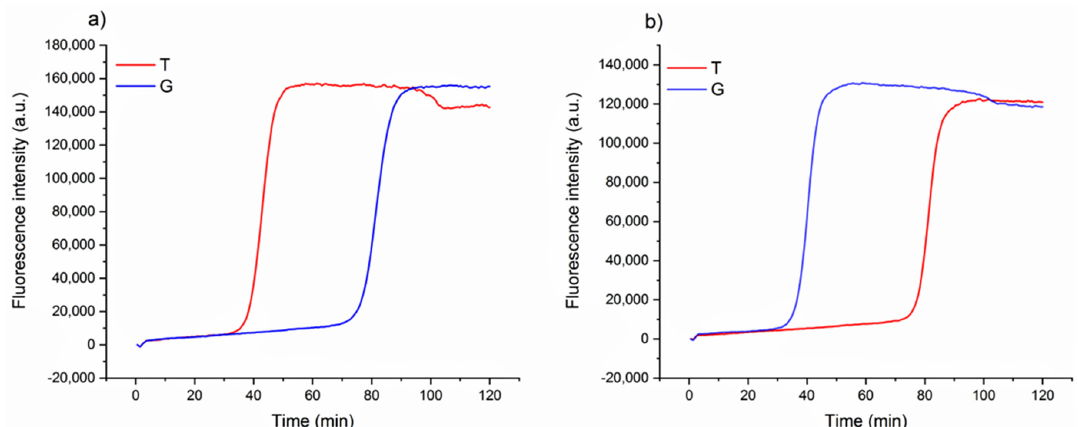
Figure 2. Real-time fluorescence detection of genetic variants of wheat. LAMP reaction with loop primer T (red line) and G (blue line) of Aureo variant genome ( a ) and one G-type variant genome (Marco Aurelio) ( b ). The time gap between fast and slow reactions is ca. 40 min. All of the reactions were performed at 63 °C.